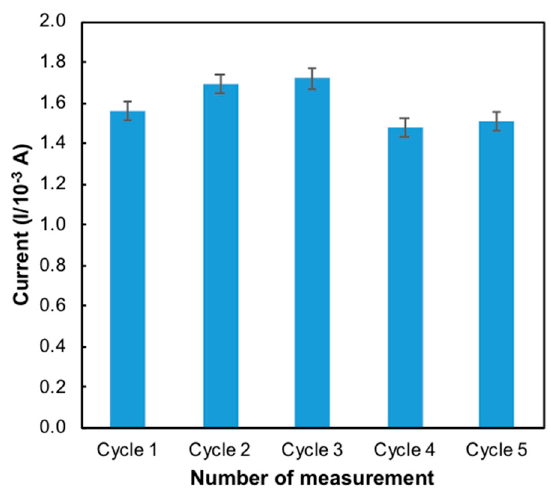
Figure 9. Bar chart of the reproducibility of the developed sensor ( n = 5 ). Table 1. Reproducibility and repeatability analysis of the modified